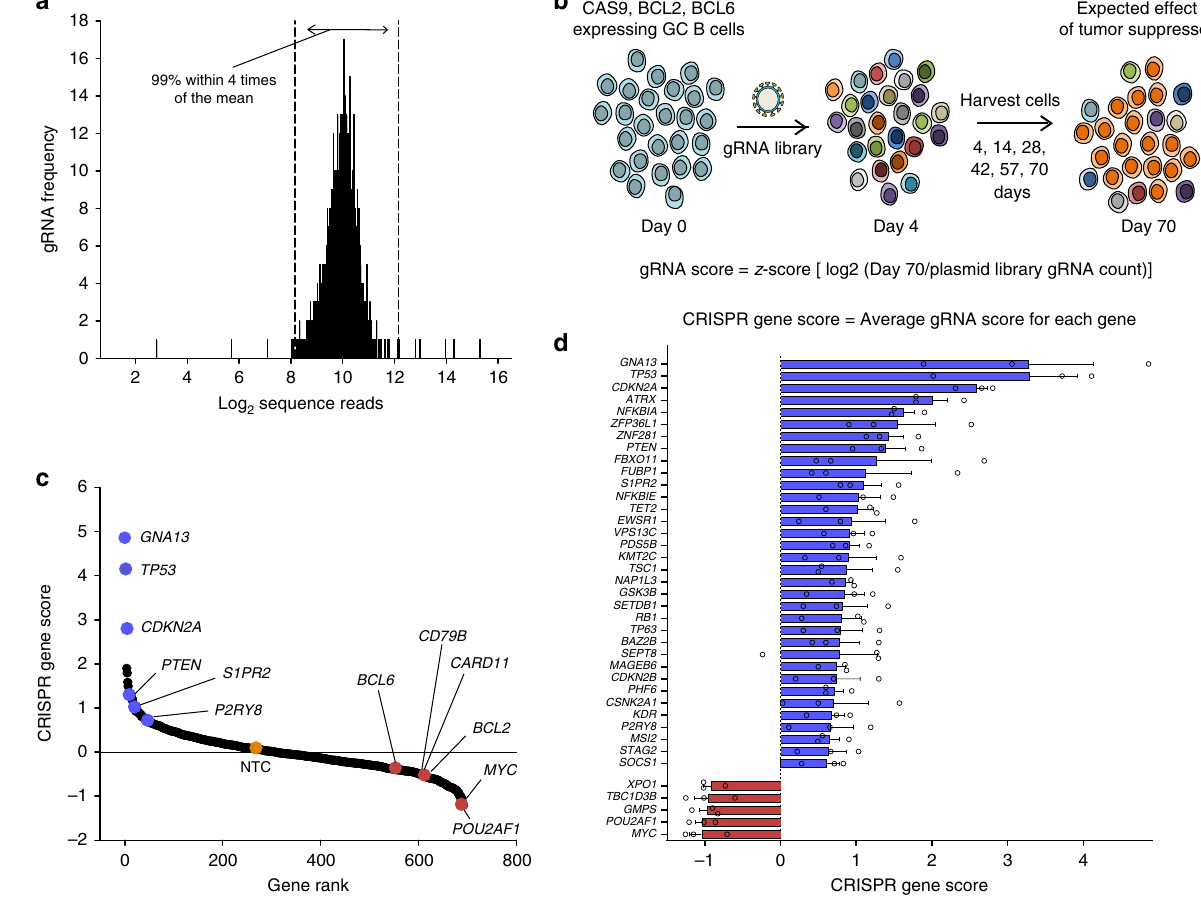
Fig. 3 Screening putative tumor suppressor genes in human primary GC B cells. a Illumina sequencing of the lymphoma-focused CRISPR library revealed that 99% of sequence reads were represented within four times of the mean. Source data are provided as a Source Data fi le. b Outline of experimental design and mathematical formulas used. c Rank-ordered depiction of CRISPR gene scores at day 70 (log2 scale) from highest to lowest. Selected tumor suppressor genes and oncogenes are highlighted in blue and red, respectively. CRISPR gene score for non-targeting control (NTC) ( n = 250) is 0.22. Representative of three experiments. d Bar graph illustrates CRISPR gene scores (log2 scale) for the top 34 enriched genes and 5 most depleted genes summarized from three independent experiments performed in separate donors. Error bars indicate ± s.e.m. for the three replicate screens. Source data